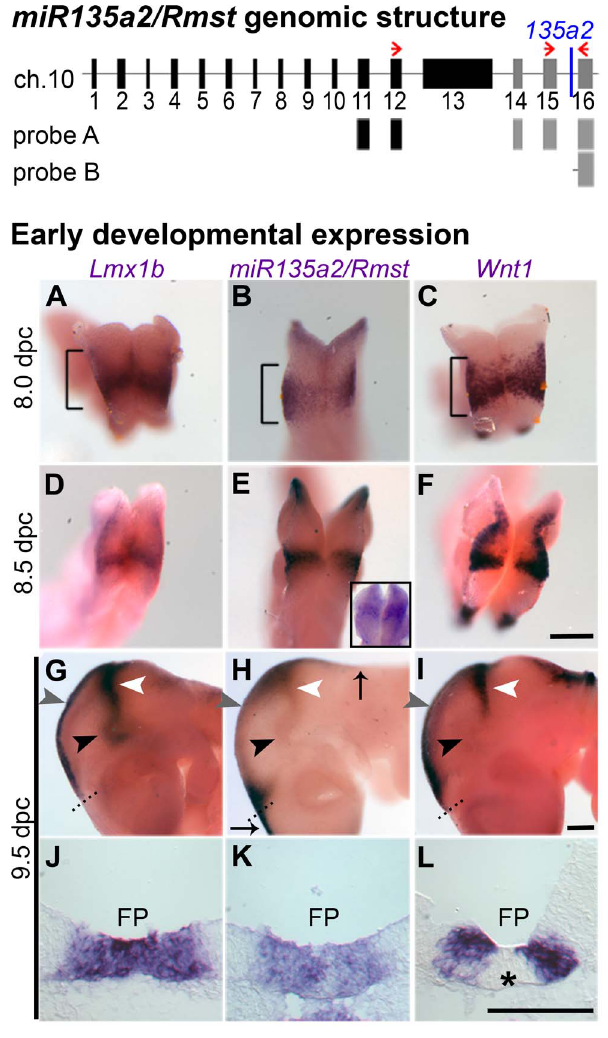
Figure 2. Identification of miR135a2 within an intron of a transcript that is expressed in a manner similar to Lmx1b and Wnt1 in the midbrain. (Top) Proposed organization of the miR135a2/ Rmst transcript. Using two different primer sets (red arrows) for RT-PCR on 11.5 dpc ventral midbrain, we revealed that the known Rmst transcript (black boxes) can be extended by three additional exons (grey boxes) and miR135a2 is embedded in the final detected intron. Two in situ probes designed to this region, probe A and probe B , show expression similar to the 135a LNA probe (see Figure S1B). (Bottom, A–L) Whole mount in situs showed widespread Lmx1b , miR135a2/Rmst , and Wnt1 in the prospective midbrain (brackets) at early time points. The 135a LNA probe (shown as an inset in panel E) had similar widespread expression. The expression of these genes was restricted to midbrain FP (black arrowhead), RP (grey arrowhead) and IsO (white arrowhead) by 9.5 dpc. Dorsally, miR135a2/Rmst hybridization extended into the hindbrain and telencephalon (black arrows). Coronal sections further demonstrate the tightly correlated FP expression of all three probes, although Wnt1 is excluded from the midline (asterisk), likely due to as yet uncharacterized repressors. Scale bars represent 100 m M.